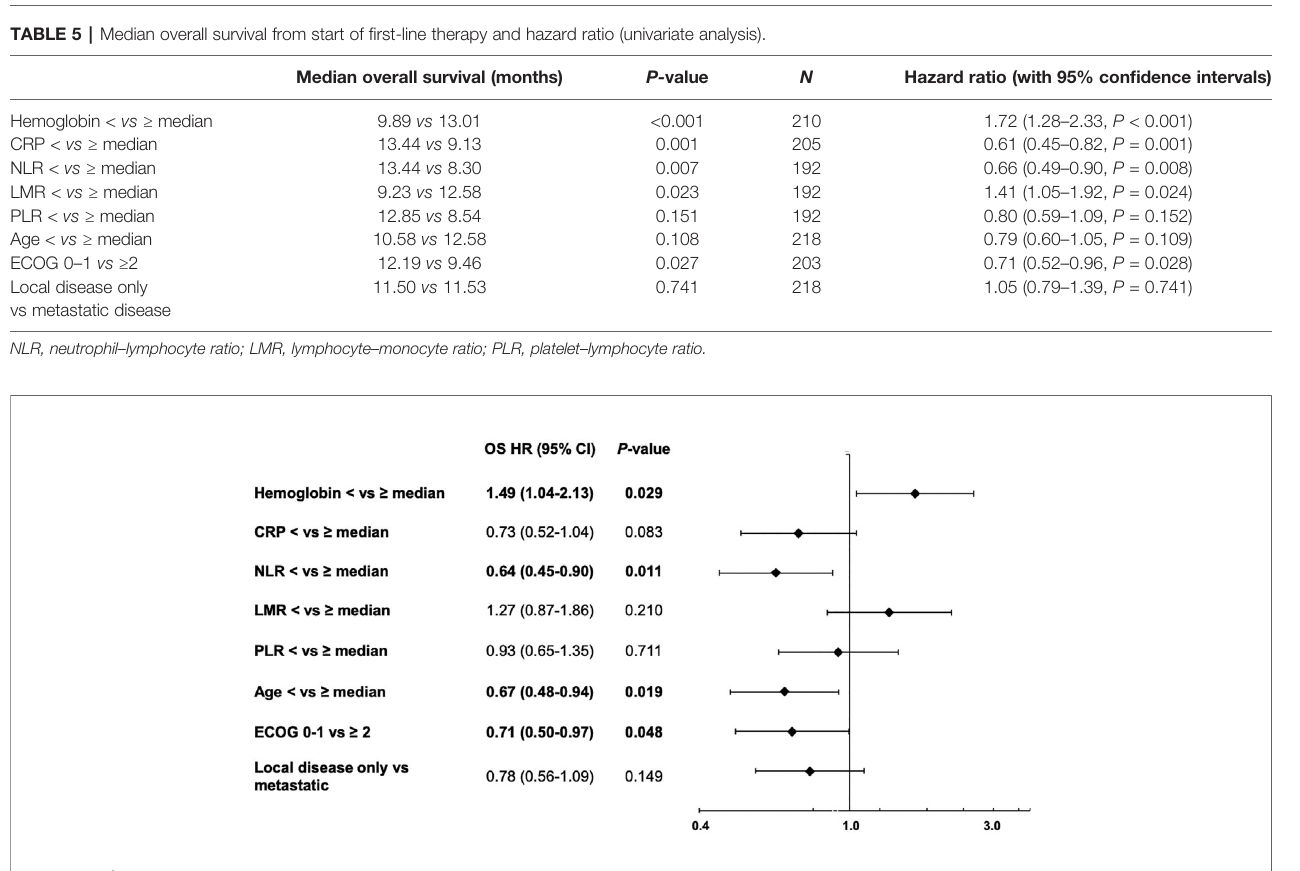
FIGURE 3 | Forest plot for the multivariate analysis of overall survival from start of fi rst-line therapy, including hemoglobin, C-reactive protein (CRP), neutrophil/ lymphocyte ratio (NLR), lymphocyte/monocyte ratio (LMR), platelets/lymphocyte ratio (PLR), age, ECOG performance status and extend of disease (local disease only vs